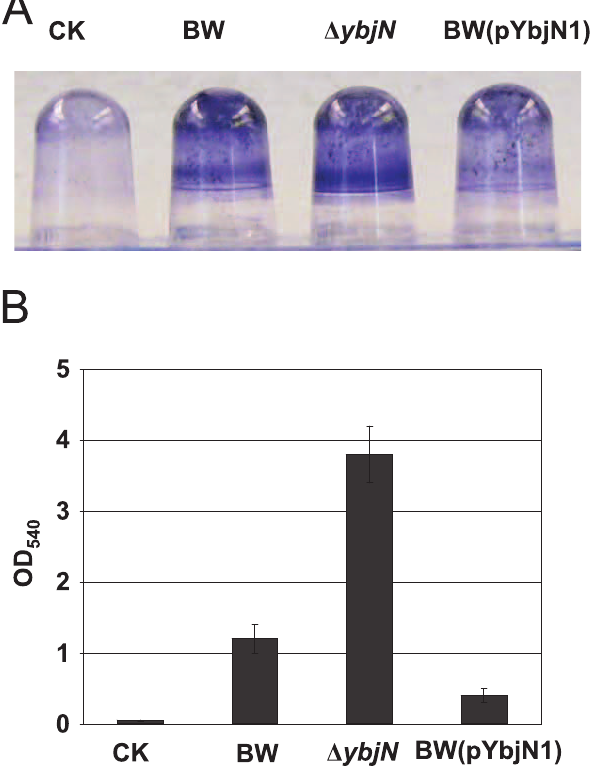
Figure 6. YbjN is a negative regulator of biofilm formation. A. All strains were grown overnight in LB broth at 30 u C, diluted (1:150) in LB and incubated at 30 u C, without shaking, in PVC plates. After 48 h, the extent of biofilm formation was assessed by staining the wells with 1% crystal violet (CV). B. Quantification of CV staining. The amount of CV staining (and therefore biofilm formation) was quantified at OD 540 . CK: negative water control.